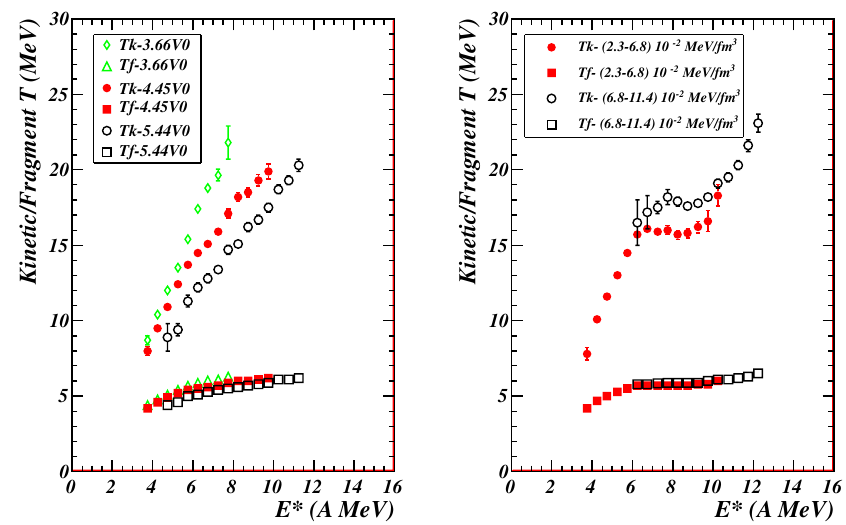
Figure 1: (Colour online) Caloric curves (kinetic temperature versus thermal ex- citation energy) constrained at average volumes (left) and for selected ranges of pressure (right) and the corresponding internal temperatures for